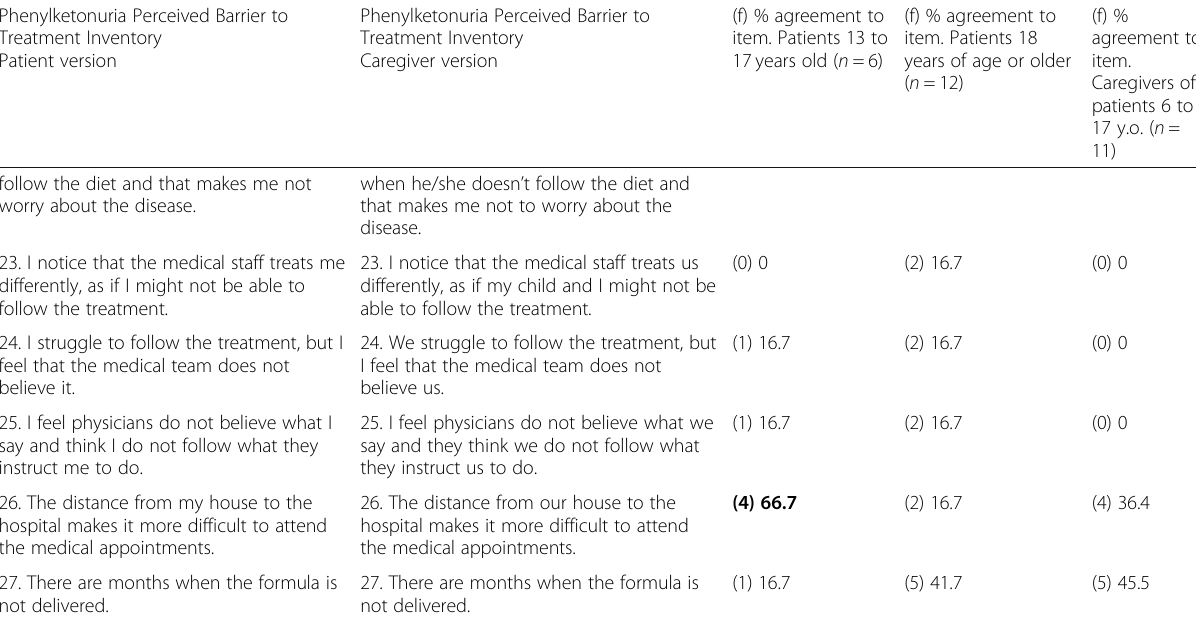
Table 4 Frequency of responses to perceived barrier to Phenylketonuria treatment by groups of adolescents, adult patients and caregivers of patients (6 to 17 y.o) (Continued)